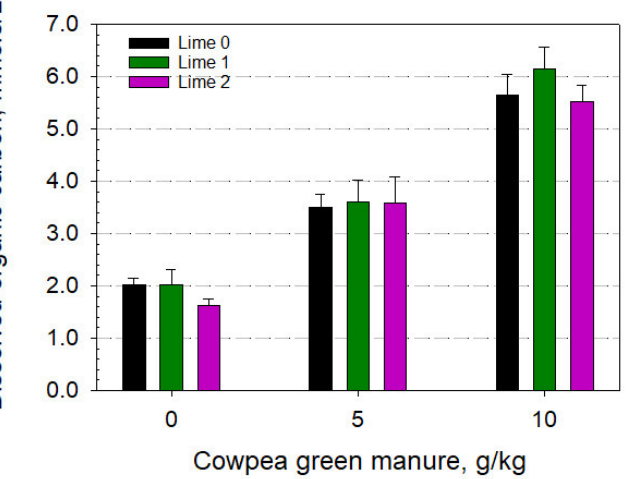
Figure 4. Dissolved organic carbon (DOC) as affected by the cowpea GM amendments to an acid Oxisol of Hawaii. Error bars on top of larger bars are standard deviation of the measured samples.